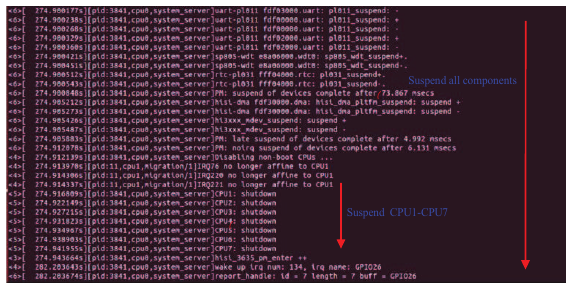
Figure 4. Switch operation flow of Suspend mode